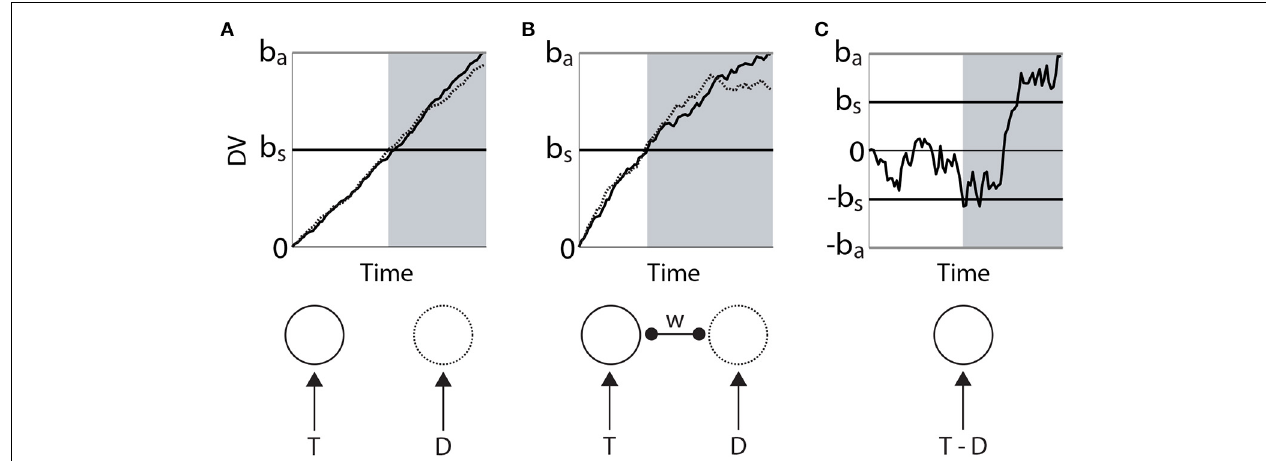
of processing time. The independence of the integrators is depicted in the lower figure. (B) Competing accumulator model. The weight (w) of subtraction between the two integrators is depicted in the lower figure. Different values of this weight would yield different curves. (C) Drift diffusion model. The decision variable is the integrated difference between the two stimuli. Black ( b s ) and gray ( b a ) horizontal lines correspond to bounds favoring speed and accuracy respectively. In each panel, the gray shaded region depicts the time of crossing of the lower (speed condition)